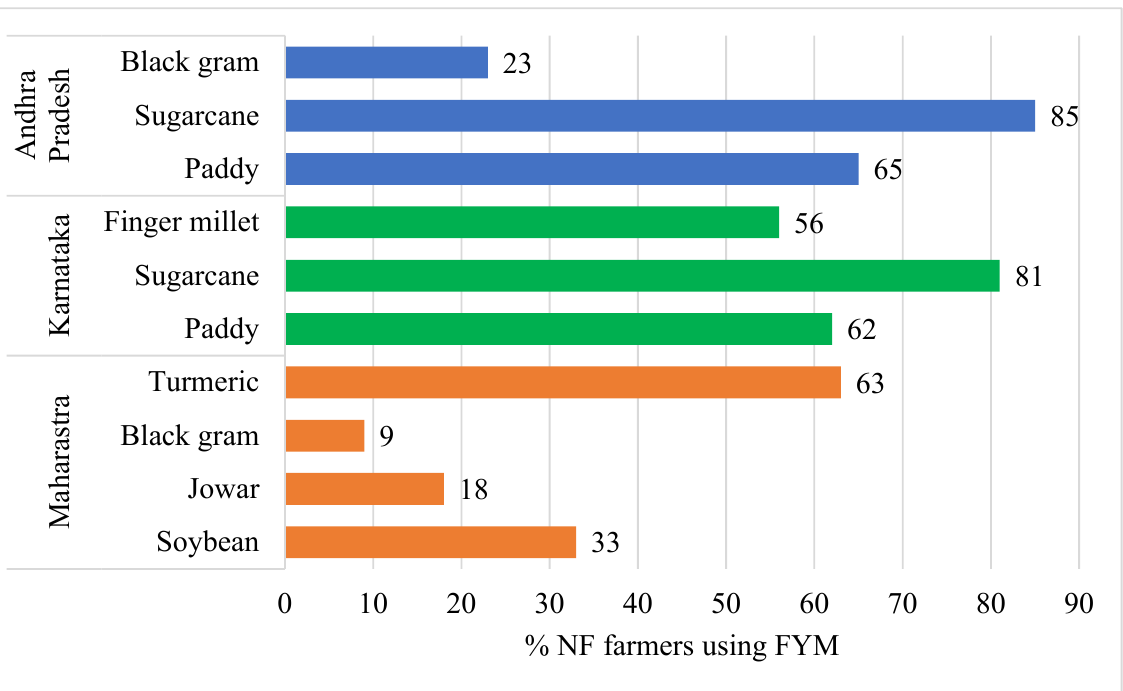
Figure 4. Crop-wise application of Farm Yard manure (FYM) by NF adopters.